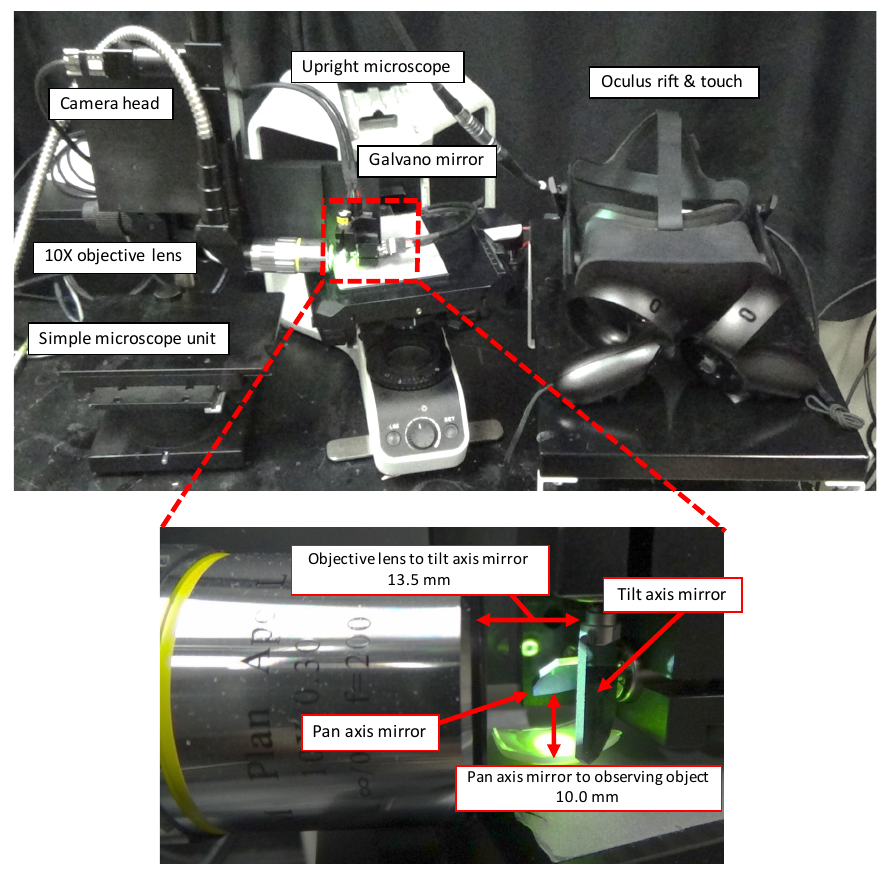
Figure 3. Overview of the proposed image presentation apparatus.